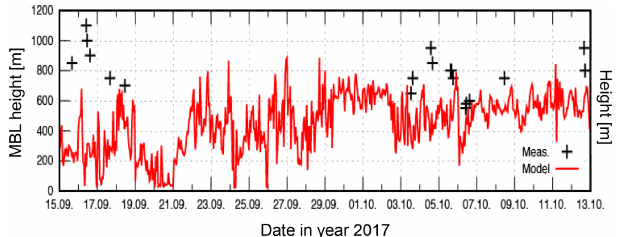
Figure 5. Time series and vertical profiles of the MBL height simu- lated with COSMO–MUSCAT on the second inner nest with a grid spacing of 0.875km (N2 domain) and measured with the